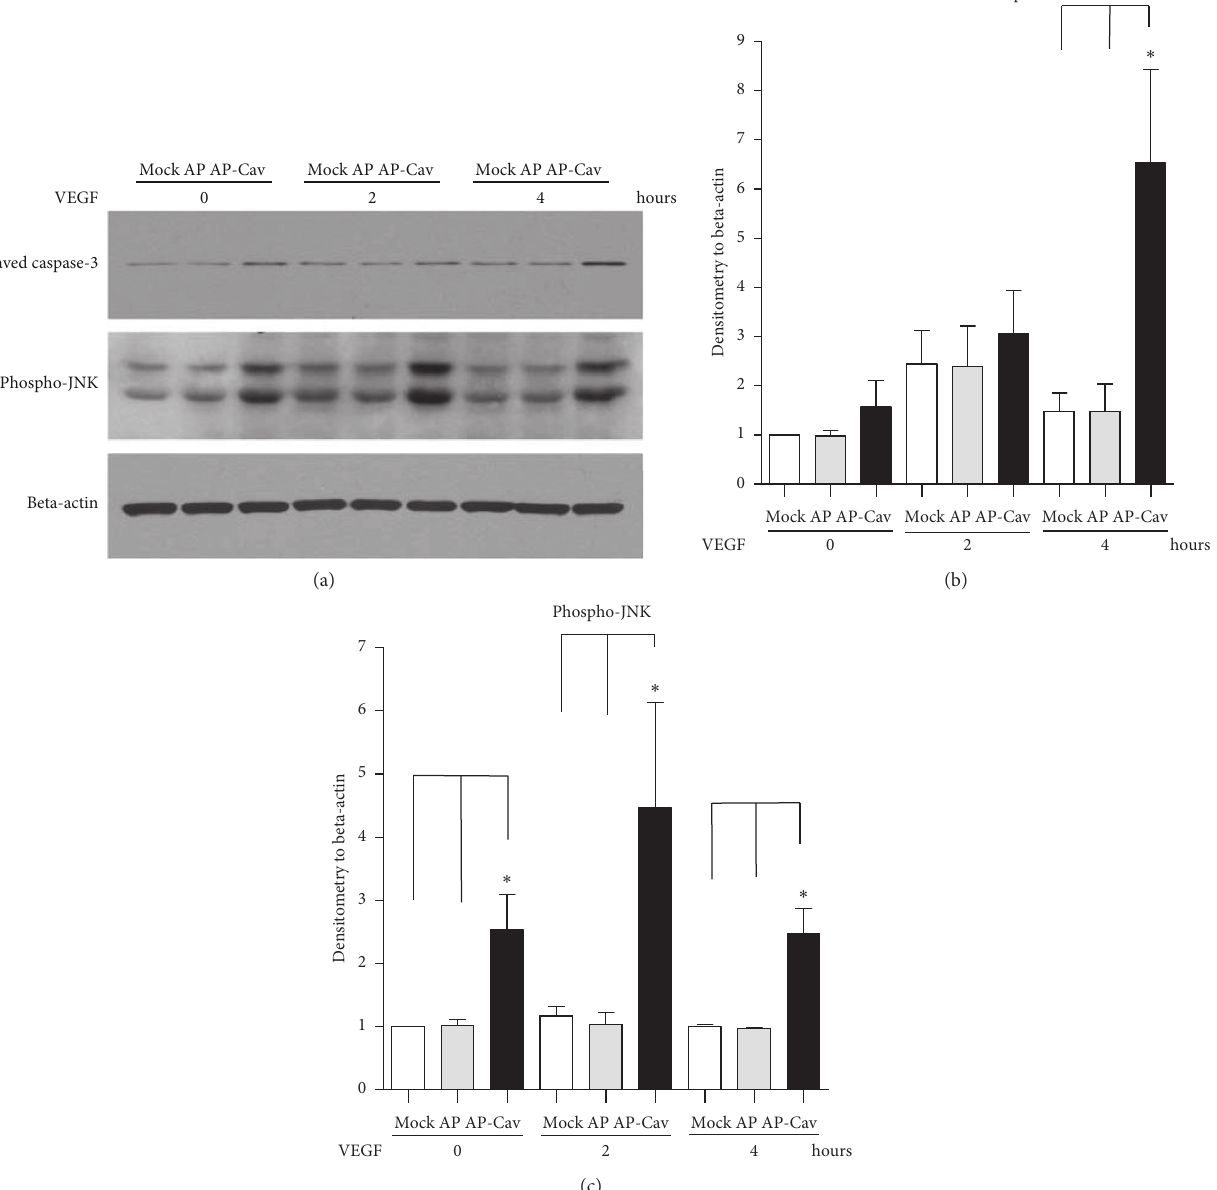
Figure 4: AP-Cav peptide upregulates caspase-3 activity and JNK activity in mouse colon endothelial cells. (a) Mouse colon endothelial cells were starved in media containing 1% FBS overnight, treated with the peptide for 30 minutes, and stimulated with 50ng/ml of VEGF for 0, 2, and 4 hours. At the end of the stimulation, cells were lysed in boiling SDS-sample buffer, and cell lysates were subjected to SDS-PAGE and western blot analysis with specific antibodies for the activated form of caspase-3 and phospho-JNK. The protein loading was probed with antibody for beta-actin. (b) Bar graph represents relative cleaved form of caspase-3 normalized to beta-actin level. (c) Bar graph represents phospho-JNK level normalized to beta-actin level. Data are mean ± s.e.m. from three independent experiments, ∗ p < 0 .